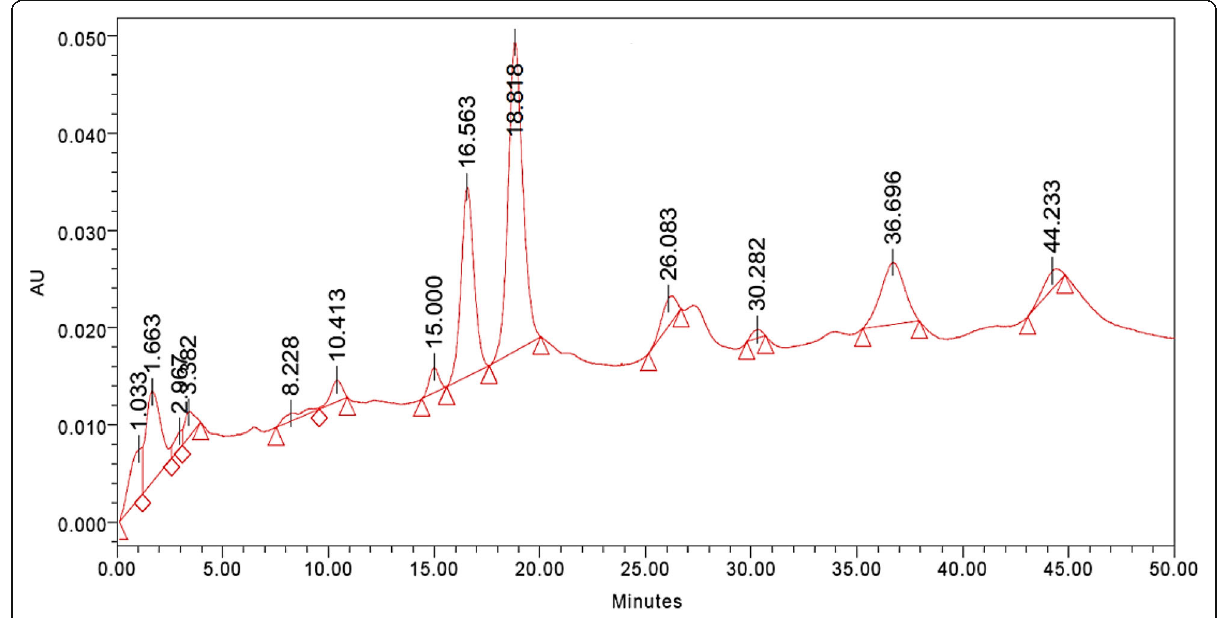
Fig. 1 HPLC peaks obtained for T. chebula